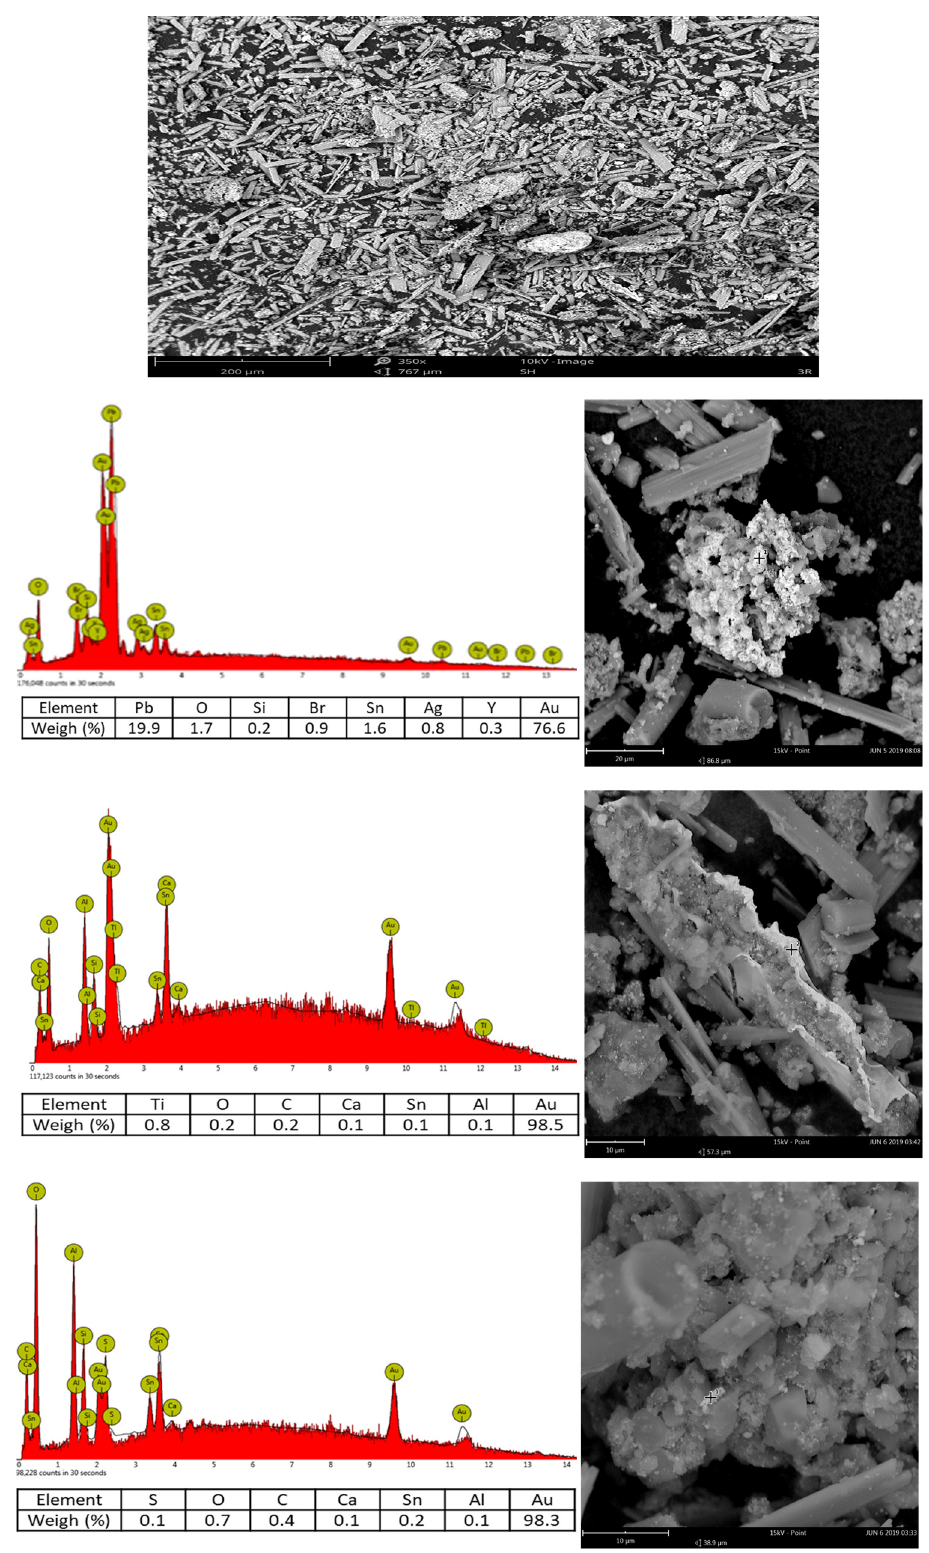
Figure 9. Scanning electron microscopy (SEM–EDS) images, a micrograph, and microanalysis of the PCB sample leached with 2 M H 2 SO 4 at 0.55 MPa and 90 ◦